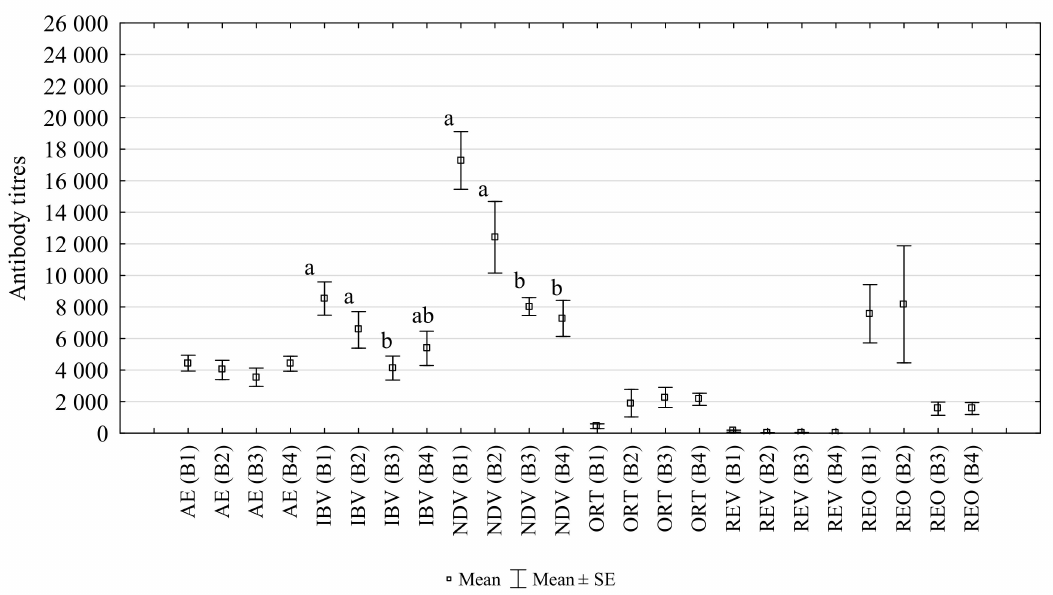
Figure 3. Changes in the titres of antibodies against AE (avian encephalomyelitis), IBV (infectious bronchitis virus), NDV (Newcastle disease virus), ORT ( Ornithobacterium rhinotracheale ), REV (reticuloendotheliosis virus) and REO (avian reovirus) in the peripheral blood of laying hens infested with D. gallinae , controlled with Biobeck. (B1–B4: blood sampling dates; a, ab, b: di ff erent letters indicate statistical di ff erences between